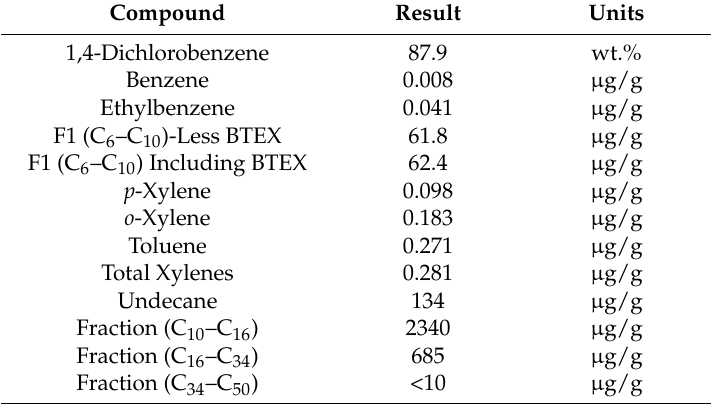
Table 3. Quantitative analysis of pyrolysis oil using a gas chromatography (GC). Compound Result Units 1,4-Dichlorobenzene 87.9 wt.%